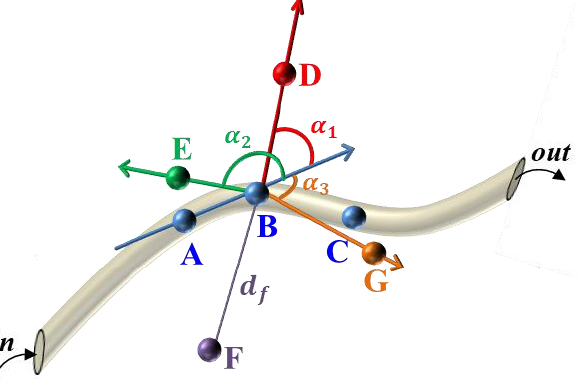
Figure 7. The types of points. “in” denotes the invasion hole, and “out” the feathering hole. The red point indicates the pioneering point; the green point indicates backward point; the orange point indicates the forward point; the purple point indicates the wrong point.